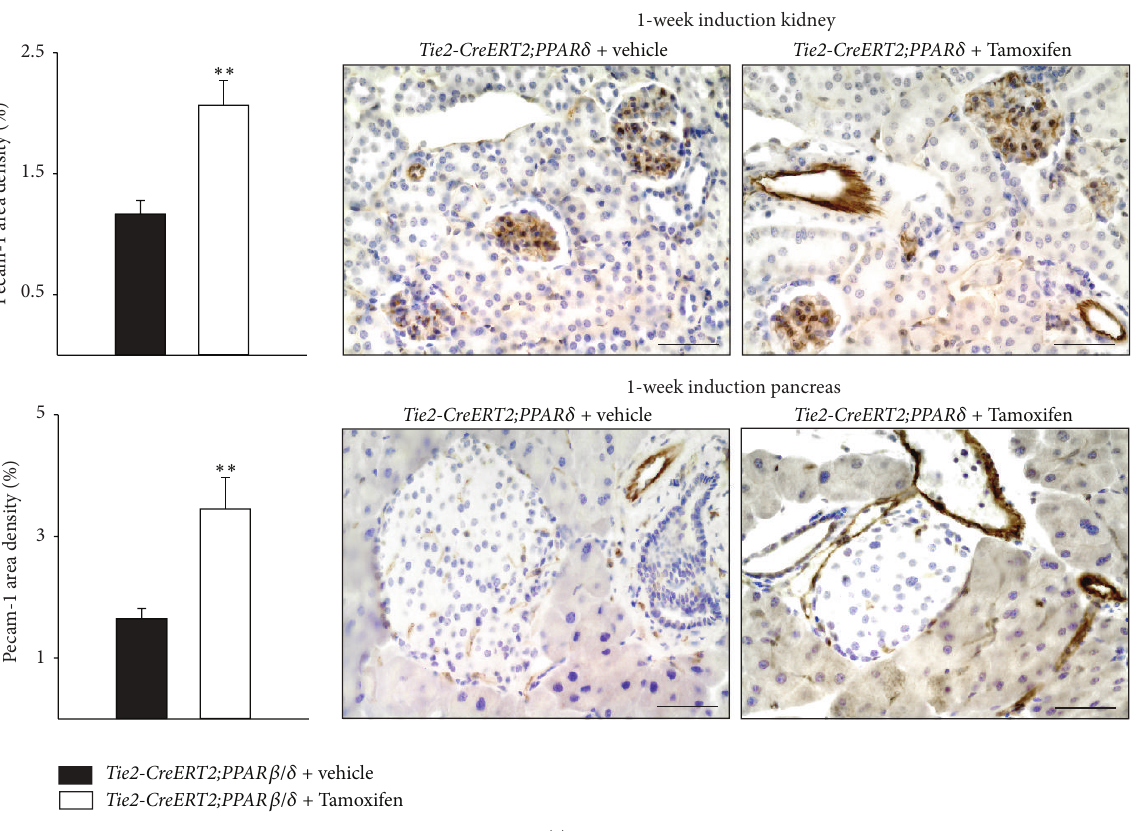
Figure1:IncreasedcardiacvesseldensityuponTie2-Cre-mediatedconditionalPPAR 𝛽 / 𝛿 overexpression.(a)PPAR 𝛽 / 𝛿 immunostainingfrom heart sections of Tie2-CreERT2; PPAR 𝛽 / 𝛿 + vehicle and Tie2-CreERT2;PPAR 𝛽 / 𝛿 + Tamoxifen animals indicates higher expression levels in the endothelium of Tie2-CreERT2;PPAR 𝛽 / 𝛿 + Tamoxifen animals. Arrows mark PPAR 𝛽 / 𝛿 positive endothelial cells. (b) Quantitative real- time PCRs for PPAR 𝛽 / 𝛿 and Calcineurin in cardiac endothelial cells from Tie2-CreERT2;PPAR 𝛽 / 𝛿 + vehicle and Tie2-CreERT2;PPAR 𝛽 / 𝛿 + Tamoxifen animals ( 𝑛 = 5 for each group). (c) Expression levels for PPAR 𝛽 / 𝛿 , Pecam-1, and eNOS determined by quantitative real-time PCRs from whole mouse heart RNA preparations for both groups ( 𝑛 = 5 for each group). (d) Pecam-1-immunostaining in mouse heart sections and quantification of Pecam-1 signal area density ( Tie2-CreERT2;PPAR 𝛽 / 𝛿 + Tamoxifen, 𝑛 = 5 , Tie2-CreERT2;PPAR 𝛽 / 𝛿 + vehicle, 𝑛 = 5 , and Tie2- CreERT2 + Tamoxifen, 𝑛 = 5 ). (e) Quantification of Pecam-1 signal area densities and Pecam-1-immunostainings in mouse kidney (upper panel) and pancreas (lower panel) sections ( Tie2-CreERT2;PPAR 𝛽 / 𝛿 + Tamoxifen, 𝑛 = 3 , and Tie2-CreERT2;PPAR 𝛽/𝛿 + vehicle, 𝑛 = 3 ). Scale bars indicate 50 𝜇 m. Data are means ± SEM. ∗∗ 𝑝 < 0.01 and ∗∗∗ 𝑝 < 0.001